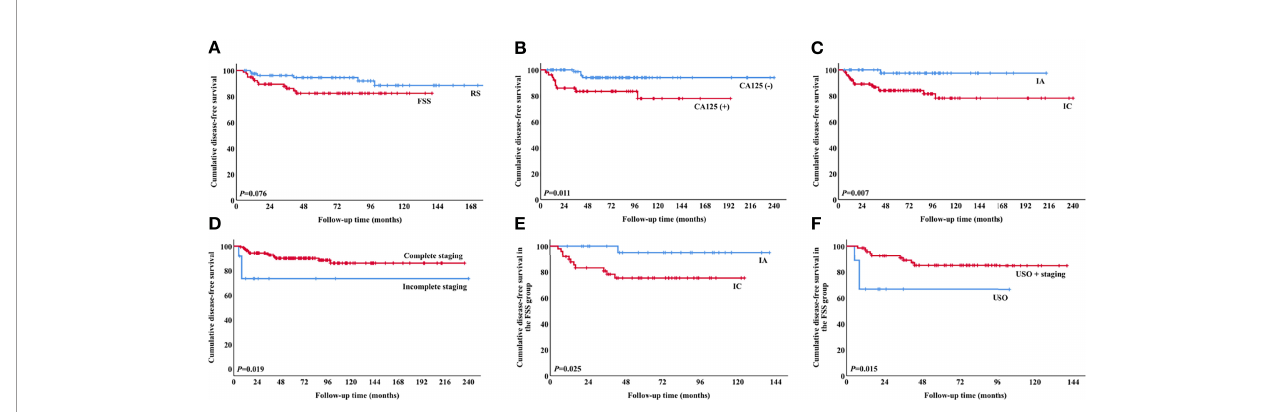
FIGURE 2 | Survival curves for patients. DFS according to (A) surgical procedure ( P =0.076), (B) preoperative CA125 values ( P =0.011), (C) stage ( P =0.007), (D) completeness of staging surgery ( P =0.019), (E) stage in the FSS group ( P =0.025), and (F) surgical procedure in the FSS group ( P =0.015). (DFS, disease-free survival; FSS,